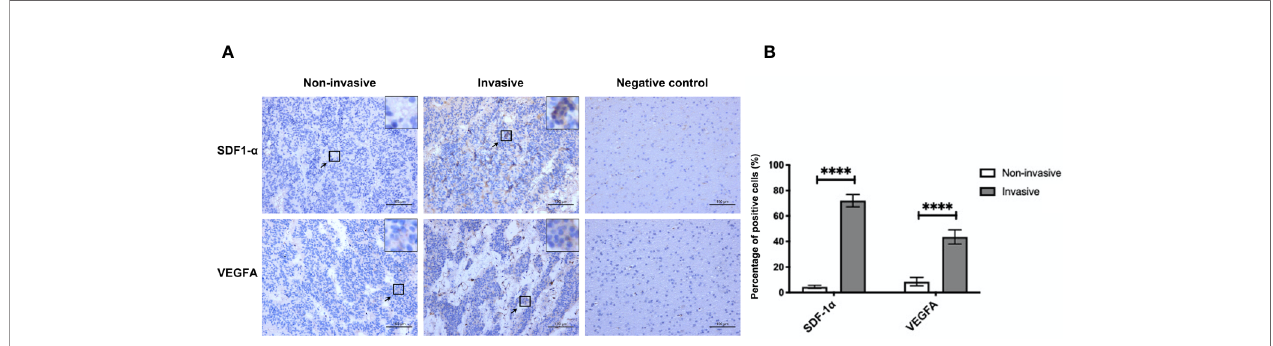
FIGURE 1 | The expression of SDF-1 a and VEGFA in invasive and non-invasive NF-PitNET. (A) Immunohistochemical staining assay of SDF-1 a and VEGFA in invasive NF-PitNET and non-invasive NF-PitNET. Brain tissues from epileptic were used for the negative control. (B) The quanti fi cation of SDF-1 a and VEGFA expression are shown between invasive and non-invasive NF-PitNET. Data were represented as means ± SD (n = 6). ****p < 0.0001 vs. non-invasive NF-PitNET group.